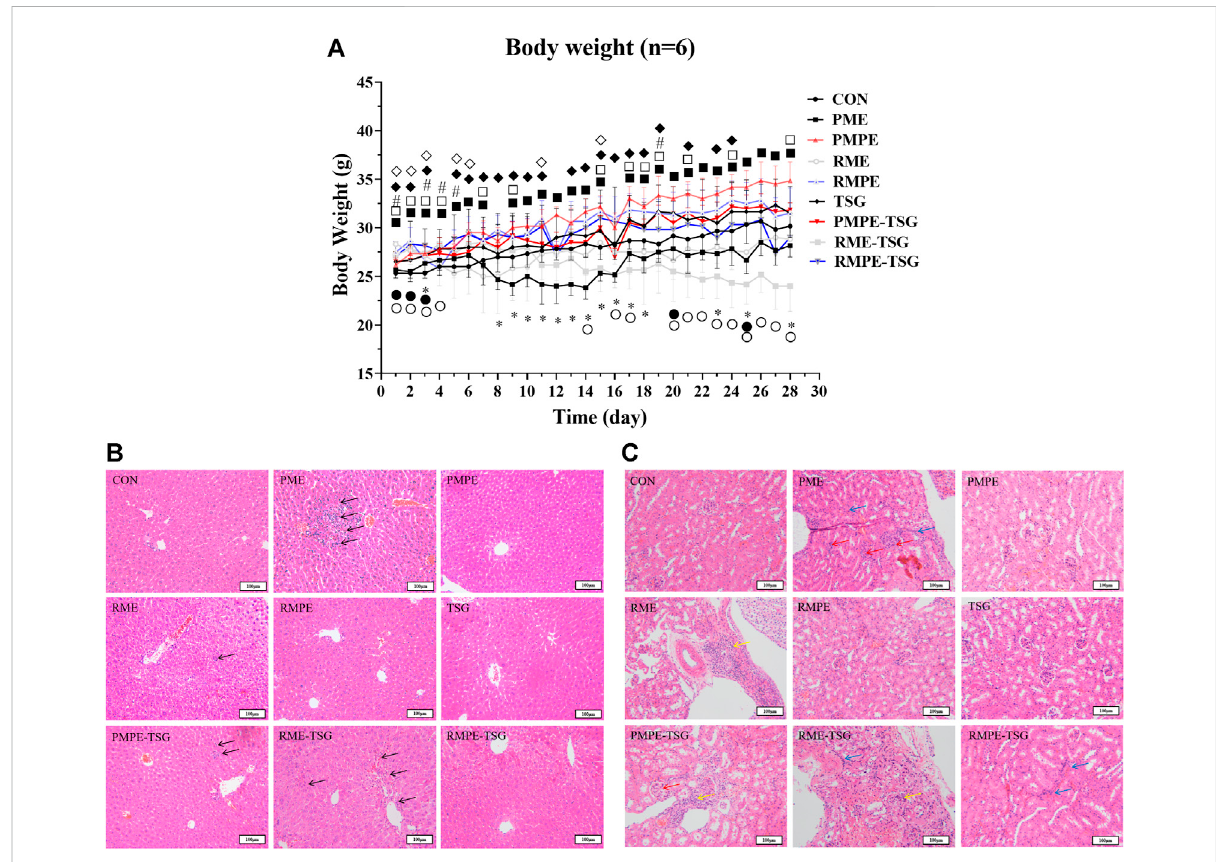
FIGURE 3 Alterations in body weight and liver and kidney morphology in mice of each group in PM hepatotoxicity study. (A) The mean growth curves of mice in all study groups. Data were expressed as mean ± SD ( n = 6); Two-tailed independent Student ’ s t -test was conducted between each experimental group and the CON group. When p < 0.05, there was a statistical signi fi cance. *: p < 0.05, PME group; ■ : p < 0.05, PMPE group; C : p < 0.05,RMEgroup; ◆ : p < 0.05,RMPEgroup;#: p < 0.05,TSG; □ : p < 0.05,PMPE-TSGgroup; ○ : p < 0.05,RME-TSGgroup; ◊ : p < 0.05,RMPE-TSG group. (B) Typical liver histological section photos of mice in each study group. The black arrow ↑ represents in fl ammatory cell in fi ltration or cell necrosis. (C) Typical kidney histological section photos of mice in each study group. The green arrow ↑ represents renal tubular epithelial cell necrosis and renal interstitial in fl ammatory cell in fi ltration, the red arrow ↑ represents the increase of glomerular cells and the atrophy of the glomerular capsule, and the blue arrow ↑ represents the increase of renal interstitial fi broblasts. Group-1: CON, Group-2: PME (8.3 g/kg), Group-3: PMPE (6.5 g/kg), Group-4: RME (10.4 g/kg), Group-5: RMPE (4.8 g/kg), Group-6: TSG (1,345 mg/kg), Group-7: PMPE-TSG, Group-8: RME-TSG, Group-9: RMPE-TSG. Each experimental group was designed to have an equivalent emodin dose of 29 mg/kg except for the TSG group, and